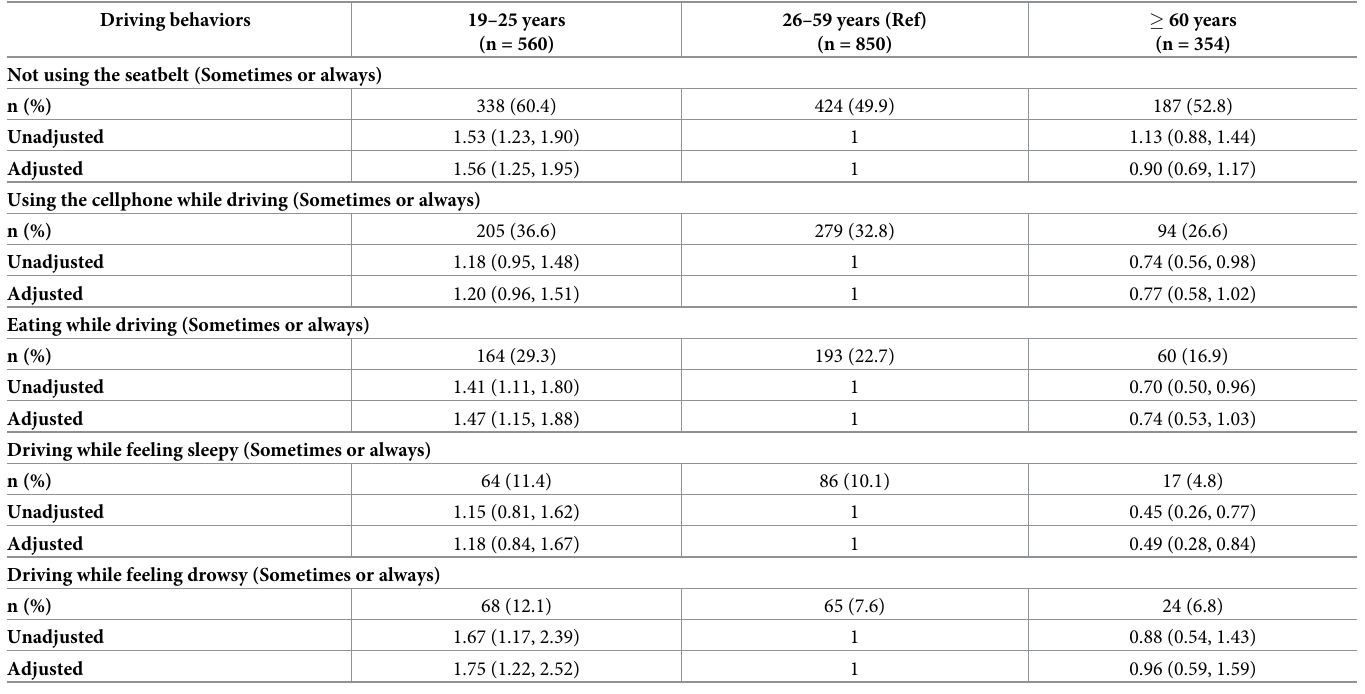
Adjusted for sex, education, vehicle model, and driving hours per day. Logistic regression was